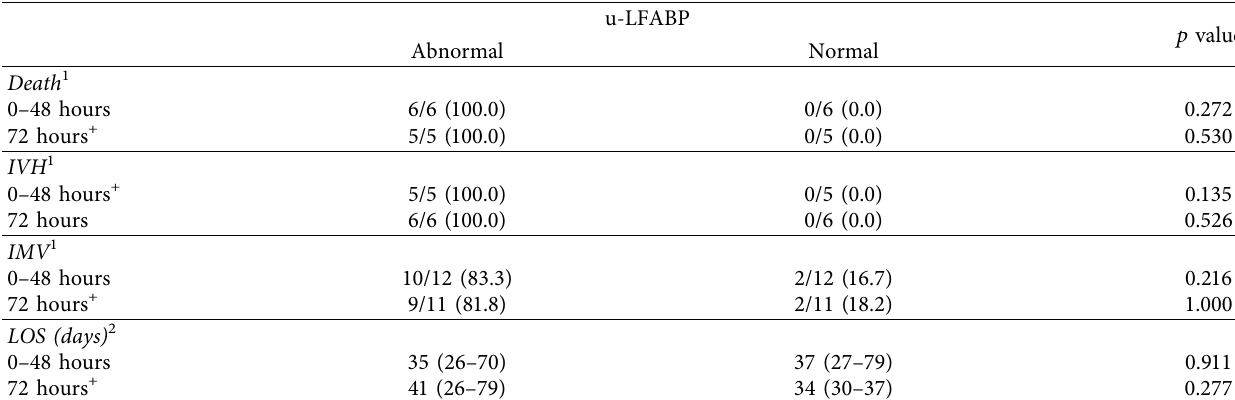
Table 4: Disease outcome associated with u-LFABP